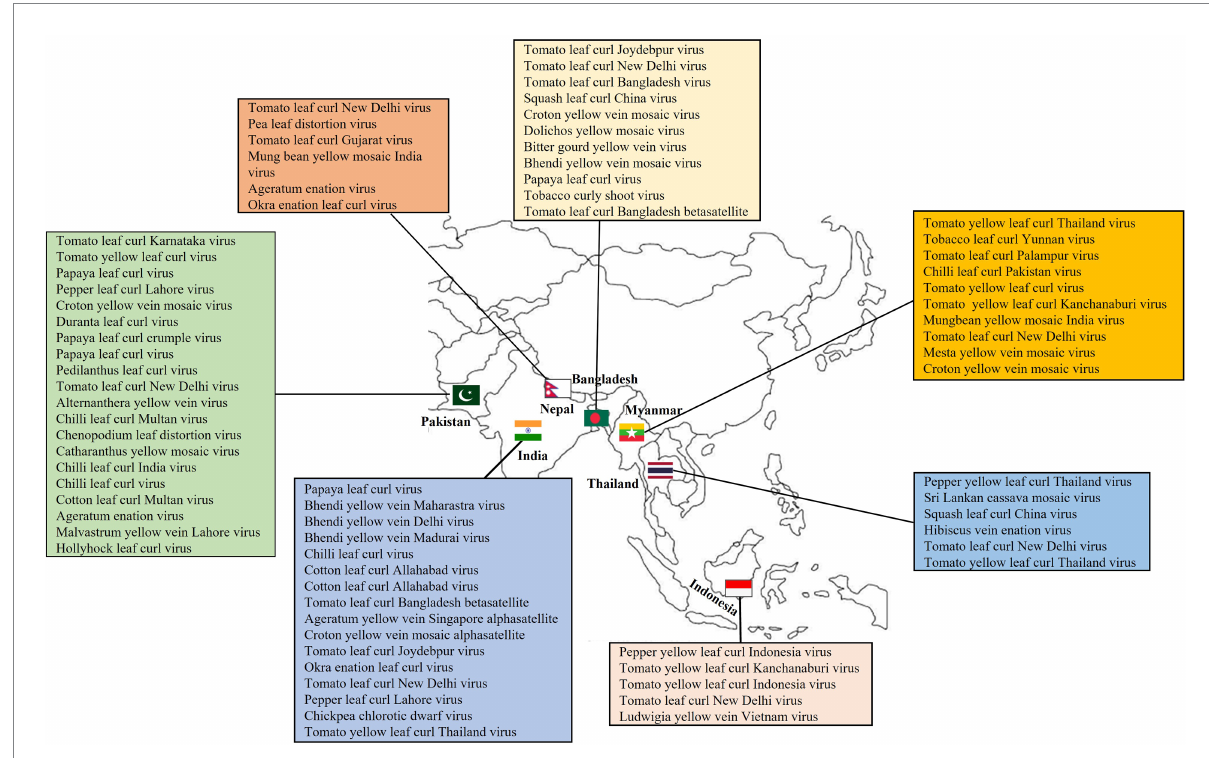
FIGURE 5 Geographical location: The map shows the distribution of some important begomoviruses in Asia.